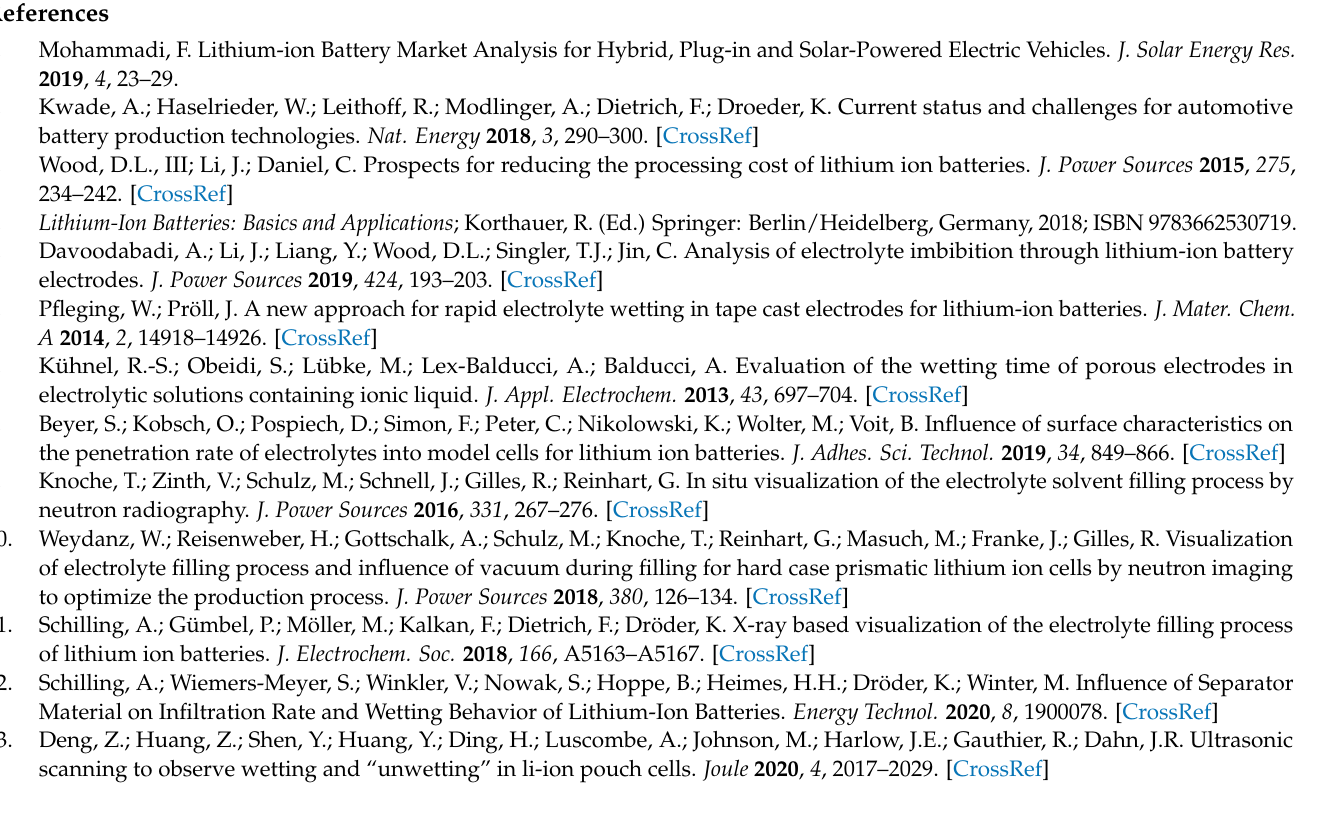
Figure A4. Images of the optical measurement of the compartment measurement series at four time points. The shape and height of the wetted visible surface are shown. Start of the measurement at t = 0 s.